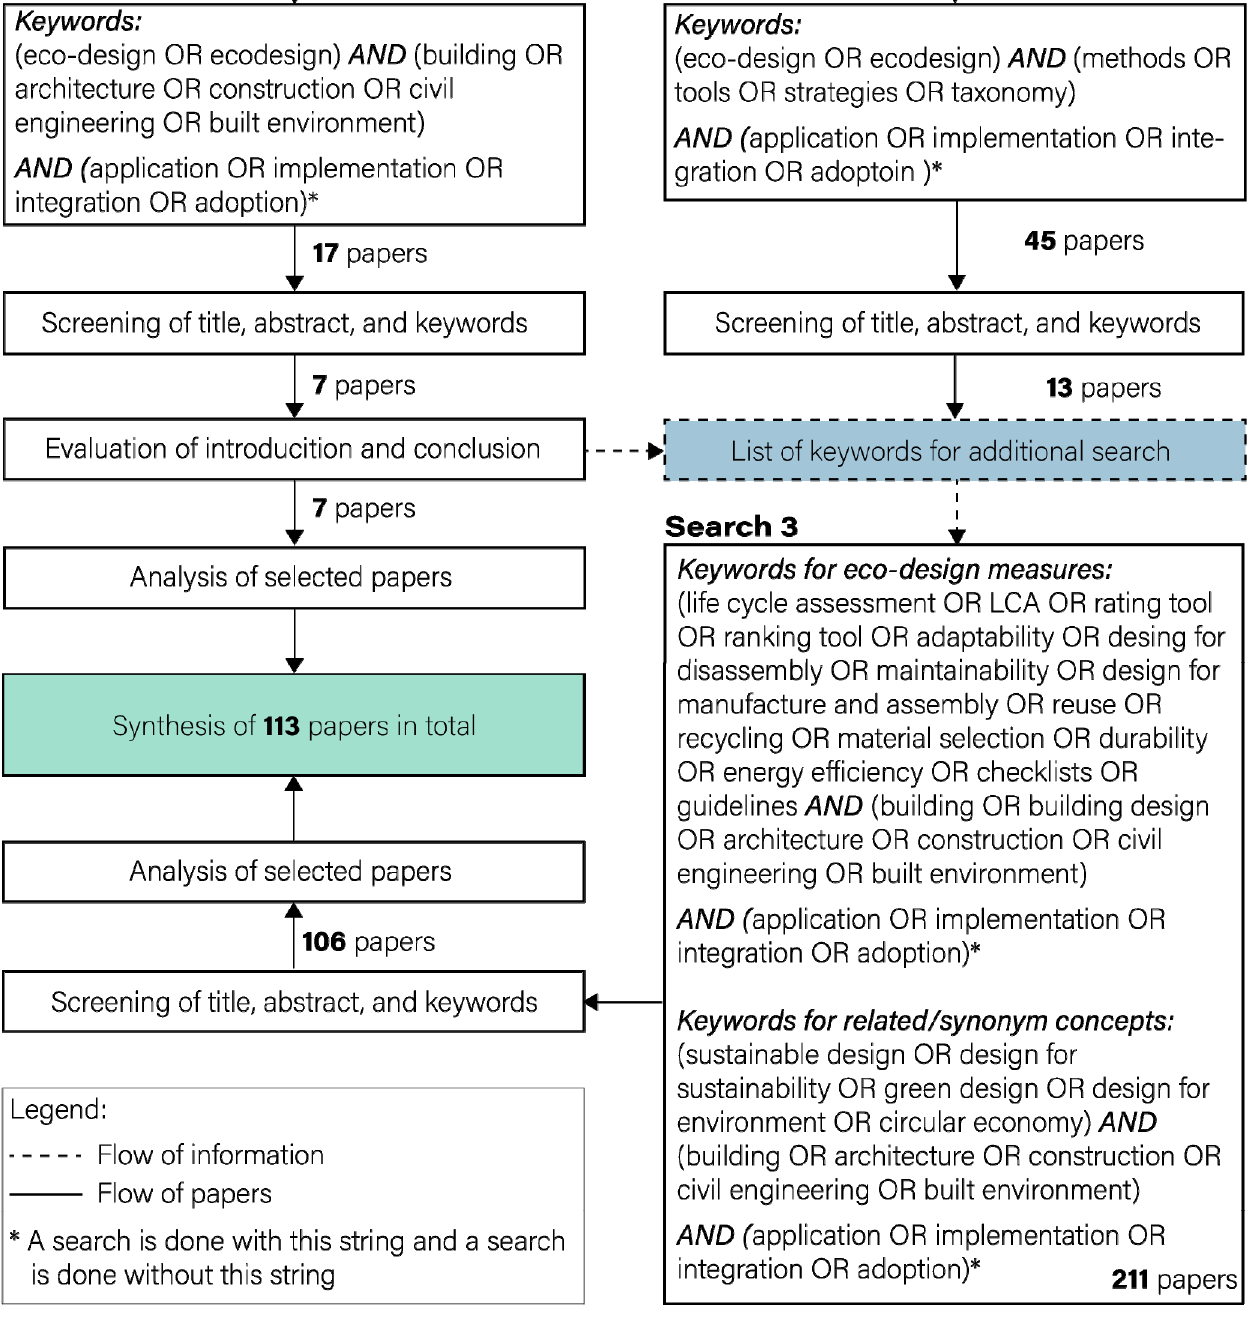
Figure 1. Schematic of the method used for conducting the systematic literature review.